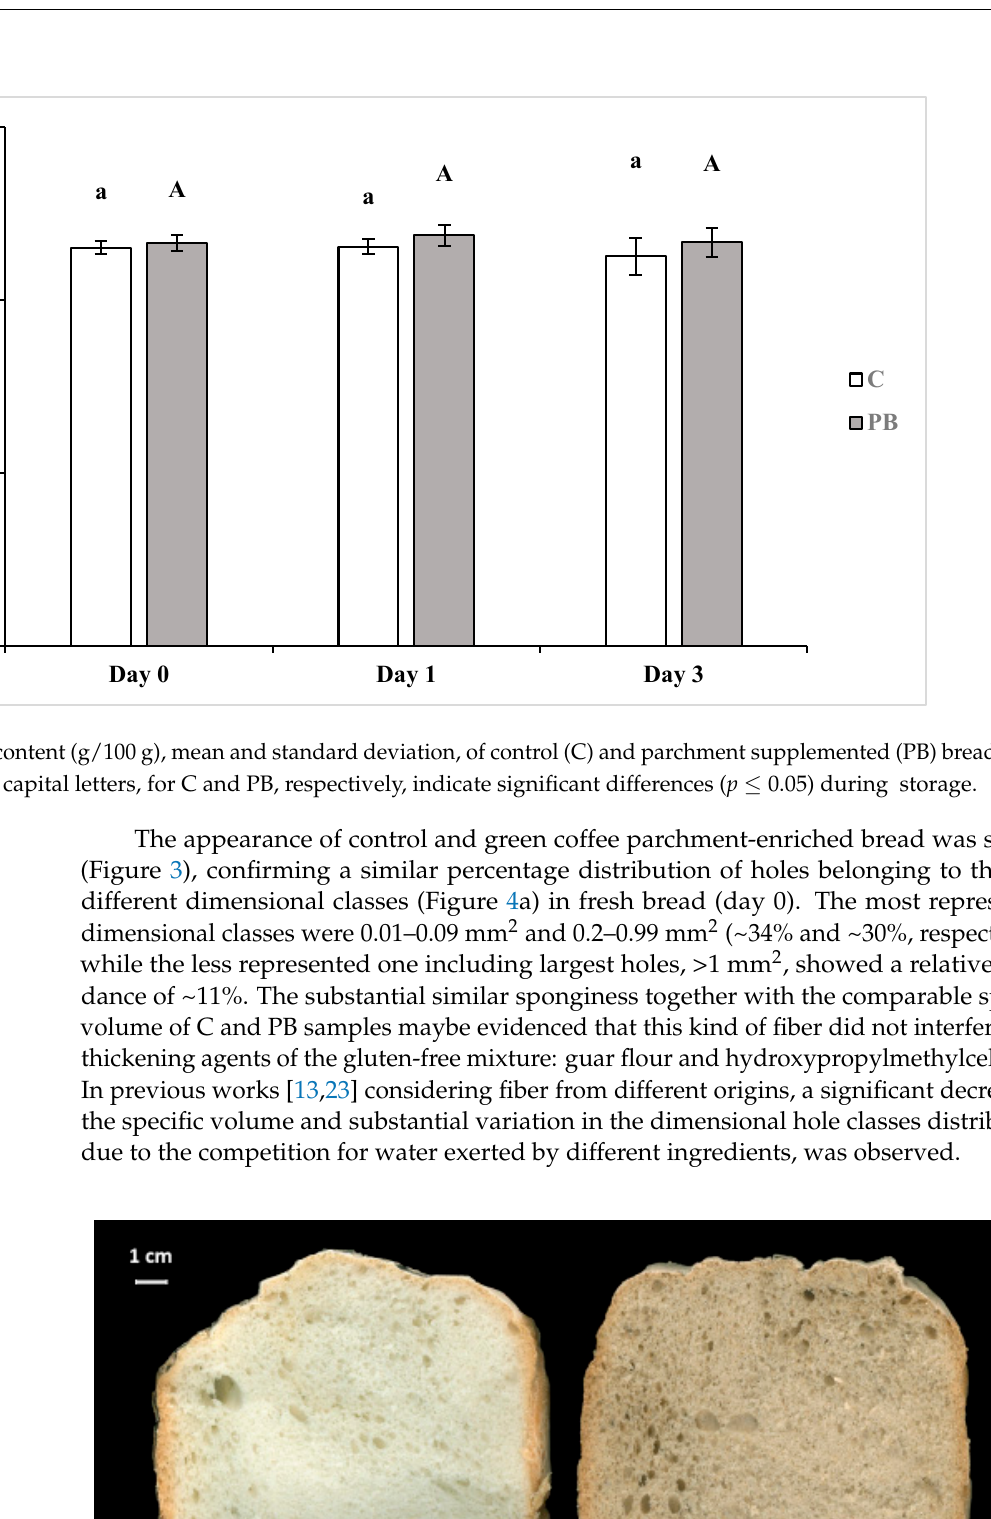
7 of 12 Figure 2. Moisture content (g/100g), mean and standard deviation, of control (C) and parchment Scheme 0. during storage. The appearance of control and green coffee parchment-enriched bread was similar (Figure 3), confirming a similar percentage distribution of holes belonging to the four dif- ferent dimensional classes (Figure 4a) in fresh bread (day 0). The most represented dimen- sional classes were 0.01–0.09 mm 2 and 0.2–0.99 mm 2 (~34% and ~30%, respectively), while the less represented one including largest holes, >1 mm 2 , showed a relative abundance of ~11%. The substantial similar sponginess together with the comparable specific volume of C and PB samples maybe evidenced that this kind of fiber did not interfere with thicken-